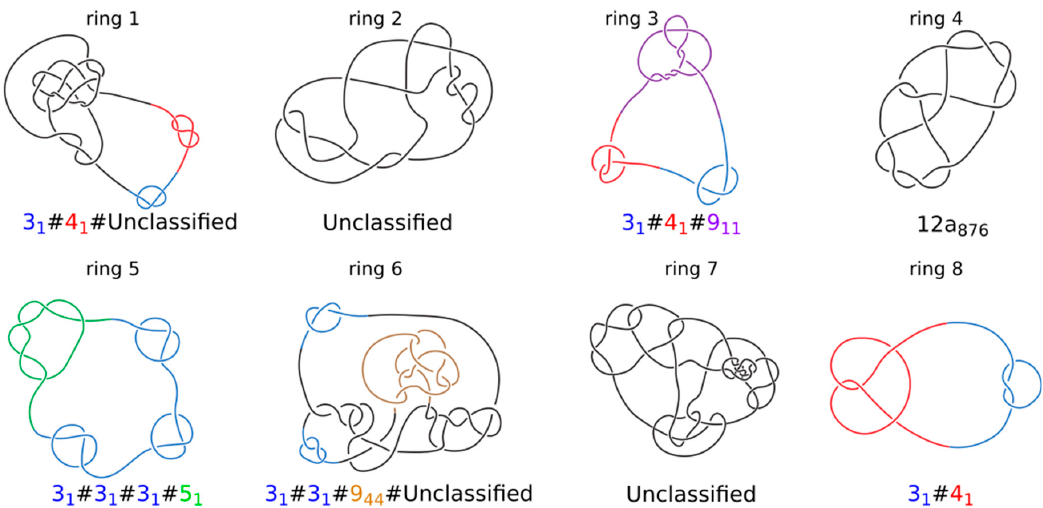
Figure 3. Topology of knotted rings formed upon topological equilibration of 8 modelled chromatin rings . Knot types of all 8 rings forming a system presented in Figure 4. Alexander–Briggs notation of knots uses two numbers to indicate the knot type. The first number written in normal font indicates the minimal number of crossings of a given knot and the second number written as a subscript indicates the tabular position of this knot among the knots with the same minimal crossing number. So for example, 9 11 indicates a knot that in tables of knots is placed at 11th position among knots which minimal crossing number is 9. The # sign indicates that a knot is formed by a composition or merging together of simpler (prime) knots that are listed as its components. For prime knots with a large number of minimal crossings, e.g., 12, as is the case of ring 4, the knots are additionally divided into these with alternating pattern of crossings (indicated as a) and with nonalternating pattern of crossings (indicated as n). Standard tables of knots do not include knots with more than 12 crossings and we indicate these knots as unclassified.